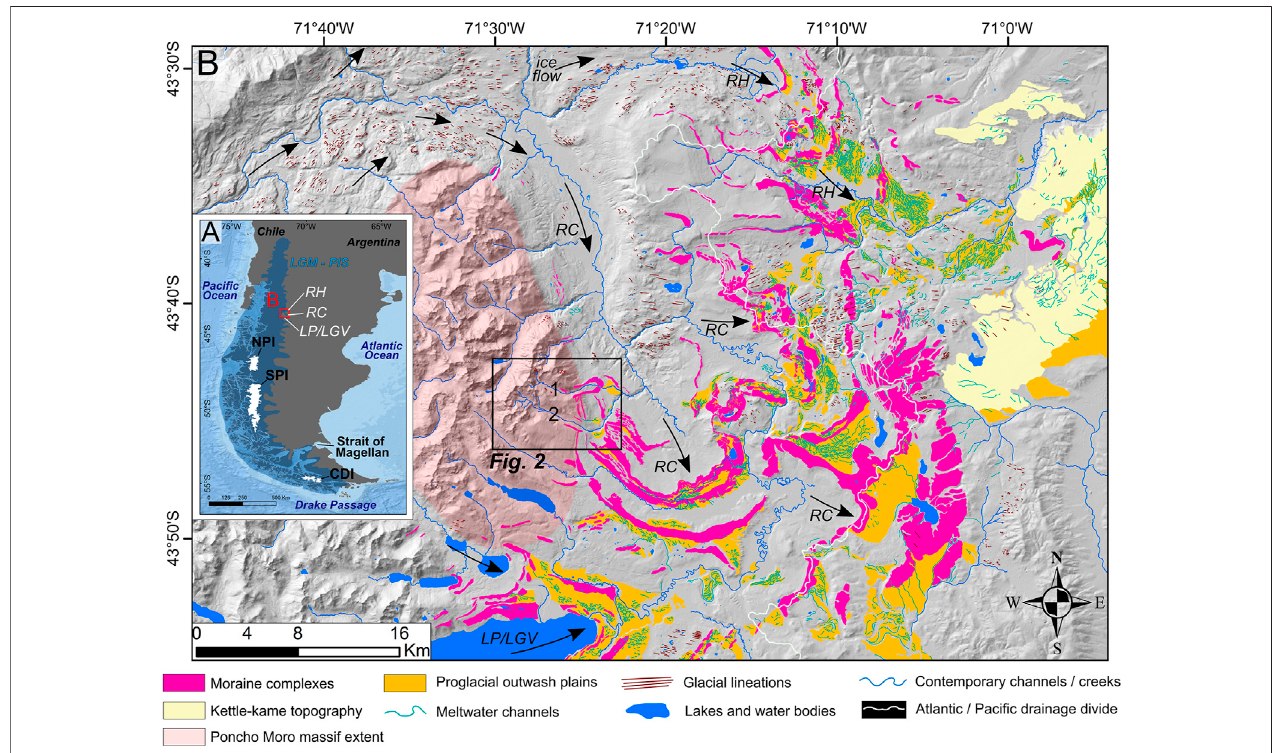
FIGURE1| Locationofstudyarea. (A) ApproximateformerextentofthePatagonianIceSheet(PIS)duringtheLastGlacialMaximum(LGM),modi fi edfromGlasser et al. (2008) (dark blue polygon). Modern extents of the North Patagonian (NPI), South Patagonian Ice fi eld (SPI), and Cordillera Darwin (CDI) Ice fi elds are displayed in white. Bathymetric data from General Bathymetric Chart of the Oceans (GEBCO). Outlet glaciers that formerly occupied the study region are designated: RC: Río Corcovado, RH: Río Huemul, LP/LGV: Lago Palena/General Vintter glaciers. Spatial data are displayed in WGS84. (B) Shaded relief map (light azimuth: 315 ° , incline: 45 ° ) based on the AW3D30 Digital Elevation Model (DEM) with overlaid glacial geomorphological data, adapted from Leger et al. (2020). Geomorphological data focusontheRC,RHand LP/LGVlateral andterminal glaciogenic deposits. Theblackbox highlightsthelocationoftheEl Loro(EL;1)and RíoComisario (RCO; 2)valleys (Figure 2) . Black arrows denote former ice- fl ow direction. The light red, transparent polygon highlights the geographical extent ofthe Poncho Moro massif. Spatial data are displayed in WGS84 and projected to UTM zone 19S.